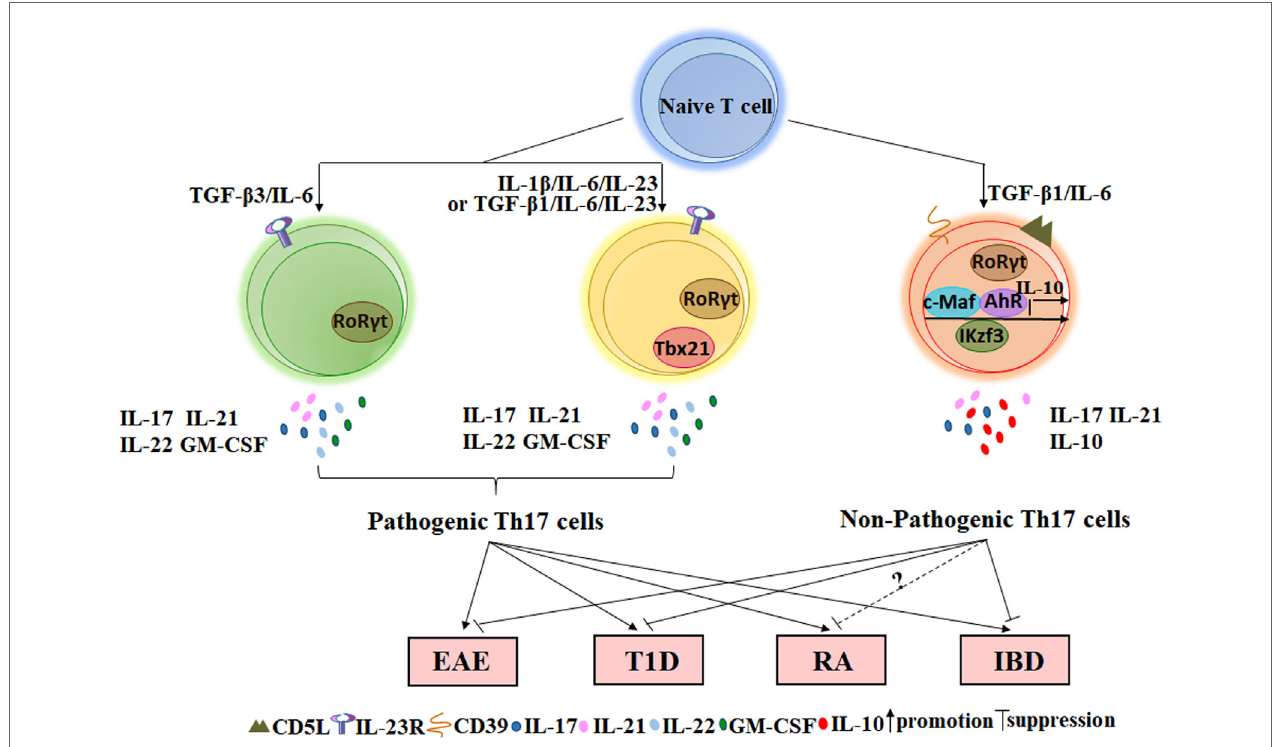
FiGURe 1 | The role of non-pathogenic Th17 and pathogenic Th17 cells on autoimmune diseases. Naïve CD4 + T cells stimulated with TGF- β 3/IL-6, IL-1 β /IL-6/IL-23, or TGF- β 1/IL-6/IL-23 in vitro can secret inflammatory cytokines such as IL-17, IL-21, IL-22, and GM-CSF and express the specific transcription factor ROR γ t. Such Th17 cells that play important roles in the occurrence of autoimmune diseases are named by pathogenic Th17 cells. However, TGF- β 1/IL-6-induced Th17 cells not only express ROR γ t but also express several IL-10-related transcription factors such as c-MAF, Ikzf3, and AhR. This type of Th17 cell expresses a low level of or lacks IL-23R but expresses a high level of CD5L/AIM and CD39 ectonucleotidases at the membrane. Adoptive transfer of Th17 cells induced by TGF- β 1/IL-6 into wild-type mice does not cause EAE or T1D. In addition, a small fraction of Th17 cells in the intestine with suppressive function can also reduce IBD via IL-10 and TGF- β . However, the effect of non-pathogenic Th17 cells on RA requires further research in mice. EAE, experimental autoimmune encephalomyelitis; T1D, type 1 diabetes; RA, rheumatoid arthritis; IBD, inflammatory bowel